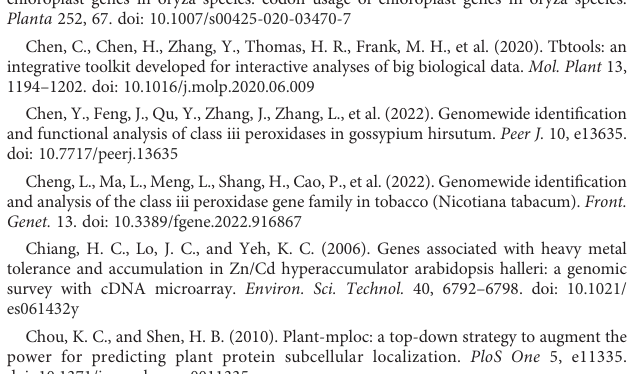
SUPPLEMENTARY FIGURE 1 Phylogenetic analysis of ShPRX proteins. SUPPLEMENTARY FIGURE 2 Analysis of gene structure and conserved motif of the PRX gene